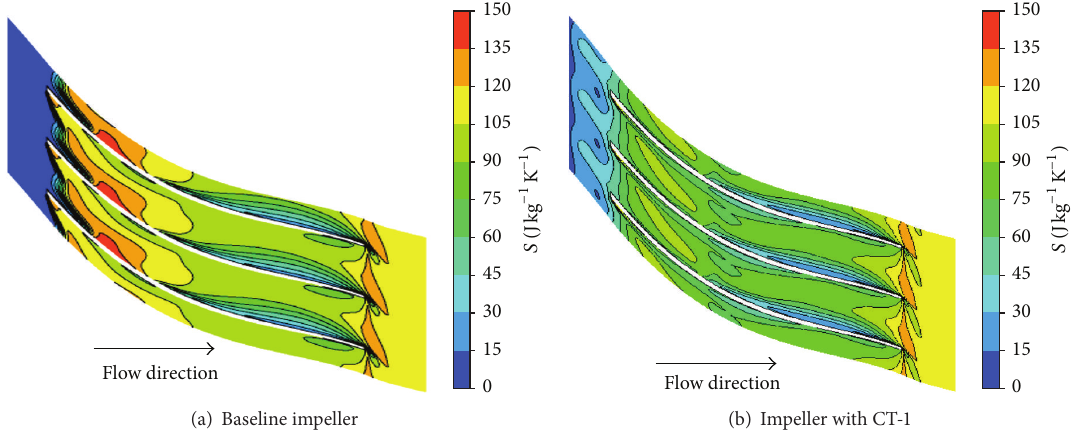
Figure 23: Entropy distribution on spanwise planes of baseline and CT-1 impellers at 90% span from hub at stall mass flow rate of baseline compressor.